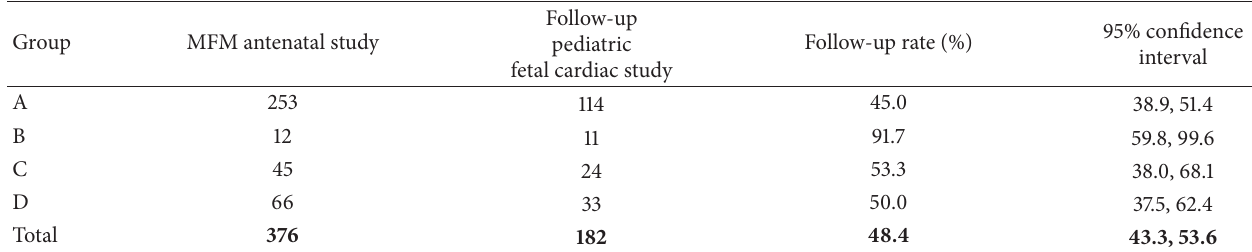
Table 1: Follow-up rates once MFM performed fetal ultrasound study have diagnosed SUA and fetal echocardiogram performed by pediatric cardiologist.